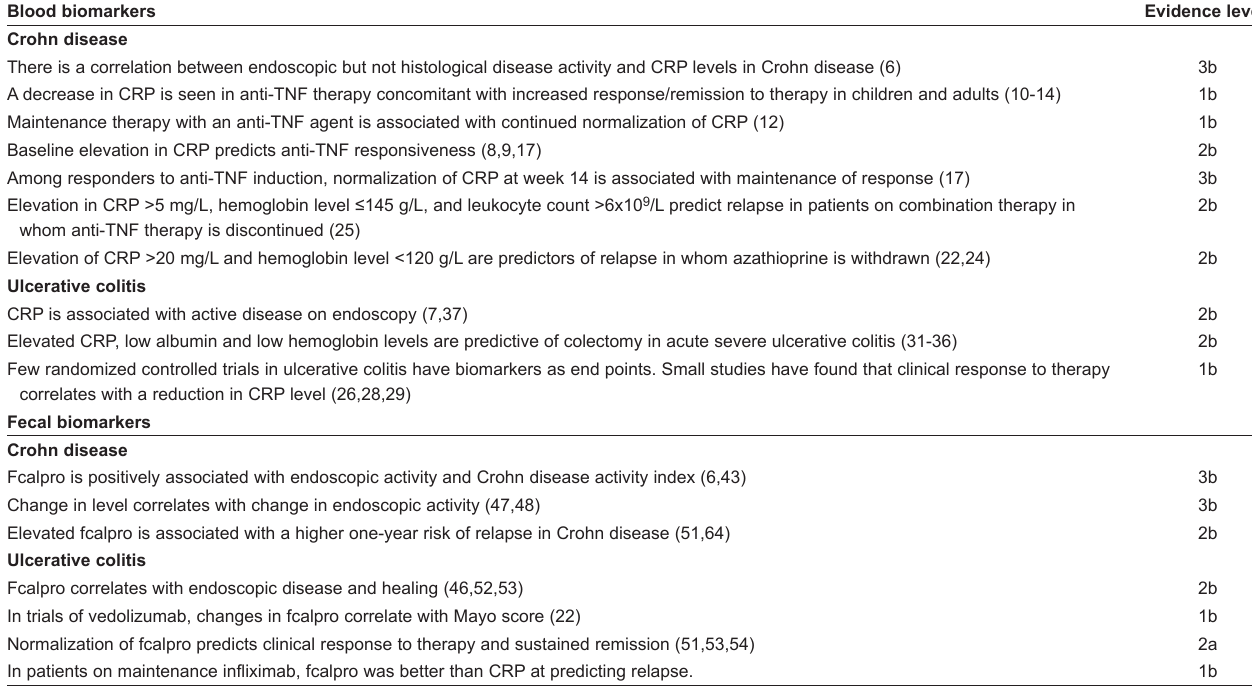
TABLE 1 Summary and evidence level of inflammatory bowel disease biomarkers Blood biomarkers Evidence